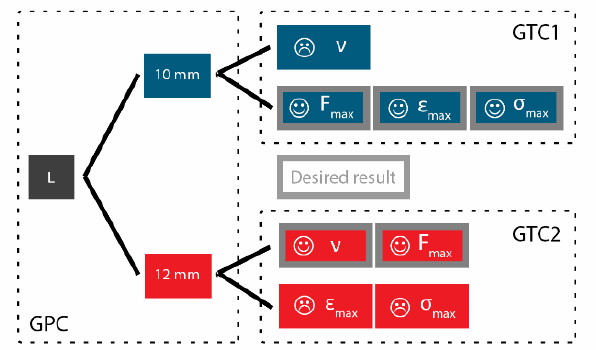
Figure 27. Generalized system of contradiction 1 with T 1 = 1.2 mm and T 2 = 3